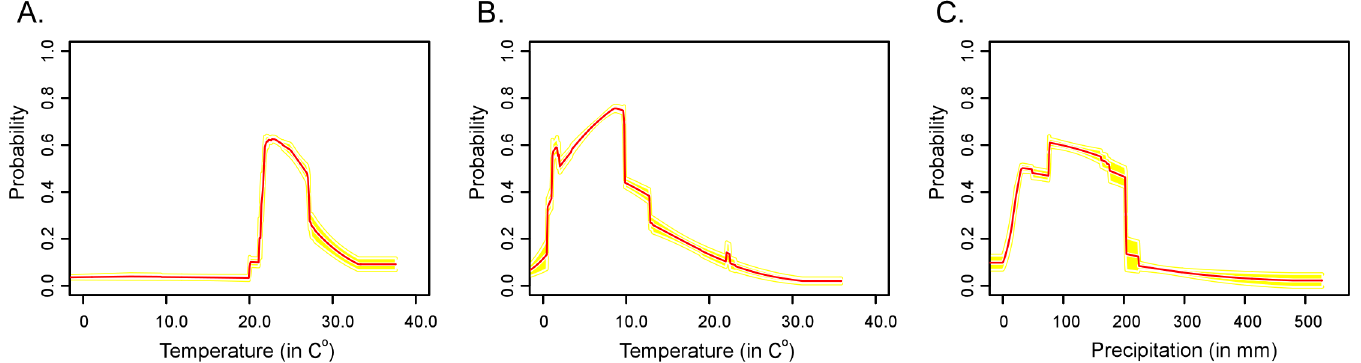
Fig 5. Three response curves with only corresponding variables in the O . turicata model: A) mean temperature of the wettest quarter (BIO8), B) mean temperature of the driest quarter (BIO9), and C) precipitation of the driest quarter (BIO17). Mean response of 10 Maxent runs (red) and the mean ± 1 standard deviation